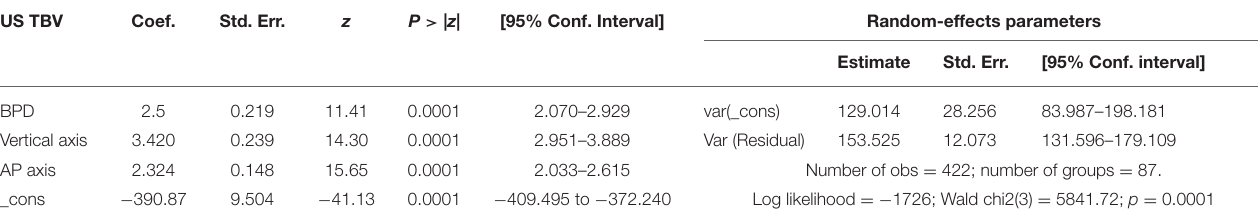
TABLE 6 | Parameters of US TBV prediction mixed effect model by three orthogonal axes (BPD, anteroposterior, and vertical axes). US TBV Coef.